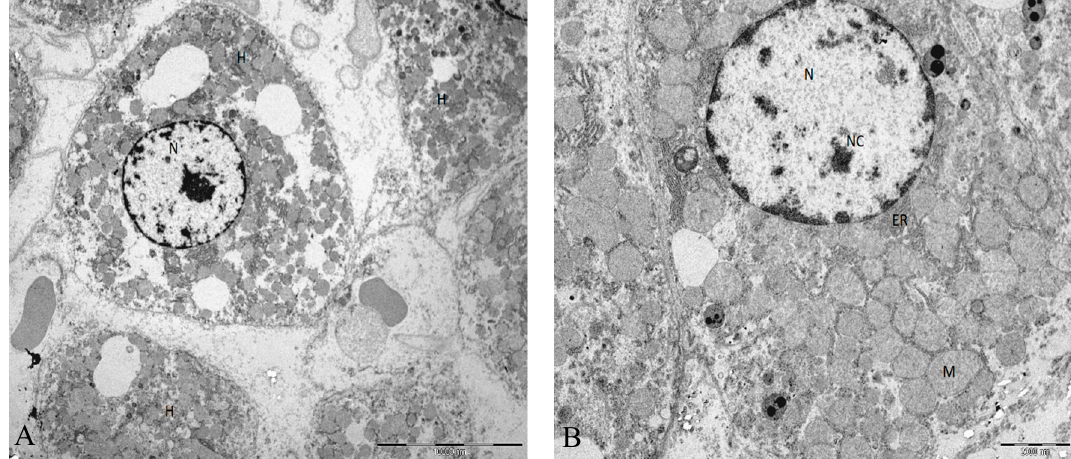
Figure 2. ( A ) Ultrastructural characteristics in rat liver tissue from animals submitted to I/R injury. Moderate to severe disassociation of the hepatocytes. ( B ) The hepatocyte adopts a rounded appearance but with regular contours. Mitochondria are homogeneous, but the main structure is maintained. Abbreviations: H, hepatocyte; N, nucleus; Nc, nucleolus; M, mitochondria; ER, endoplasmic reticulum. Scale bar ( A ): 10000 nm ( B ) 2000 nm.